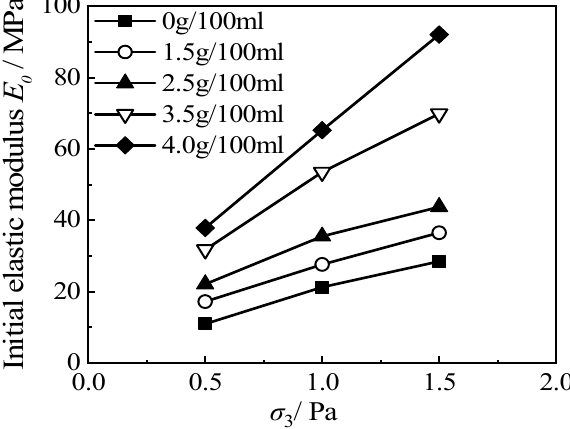
Figure 10. The E 0 ~ σ 3 /Pa curve of RCS soil with 20% rubber content.